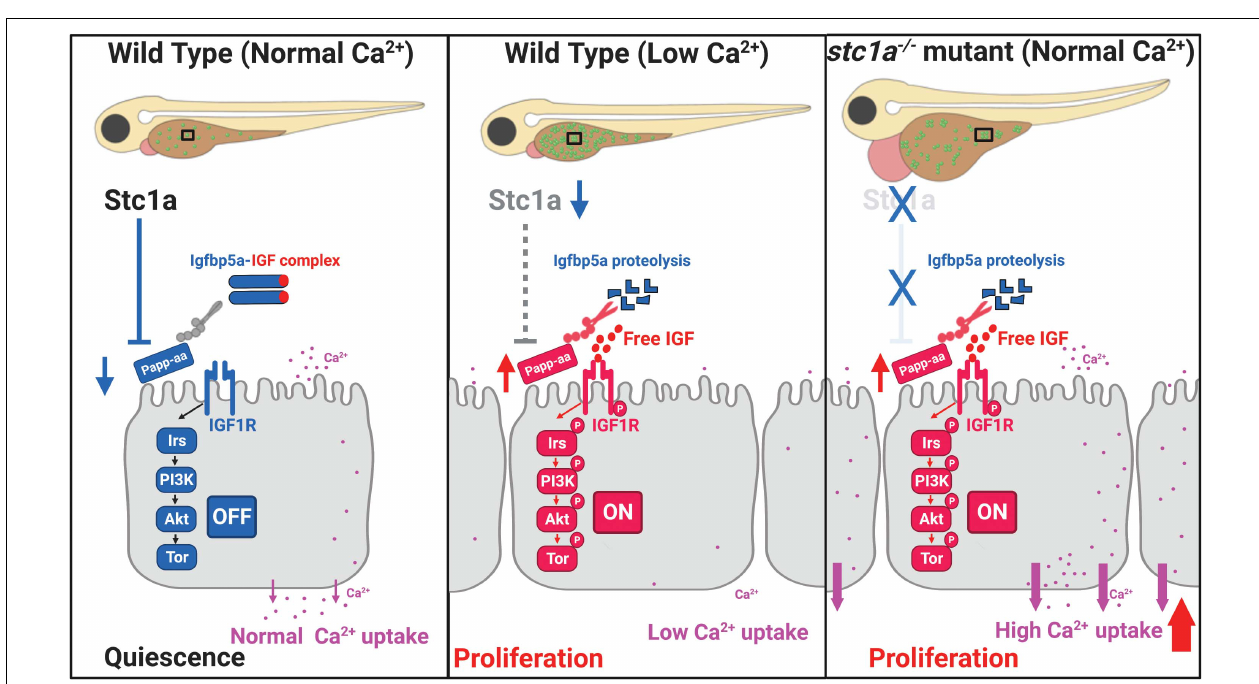
FIGURE 7 | Proposed model of Stc1a function as a [Ca 2 + ] state-regulated regulator of local IGF signaling and its role in epithelial cell quiescence-proliferation balance.